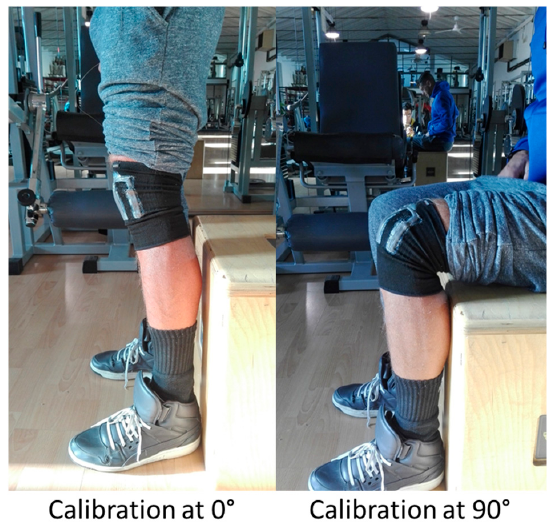
Figure 15. Kneepad calibration.